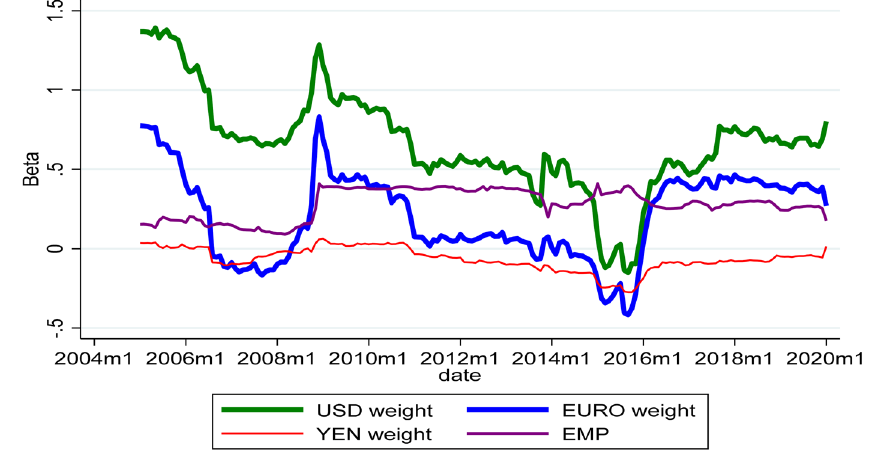
Fig. 3 Rolling window Frankel–Wei regressions (coefficients)